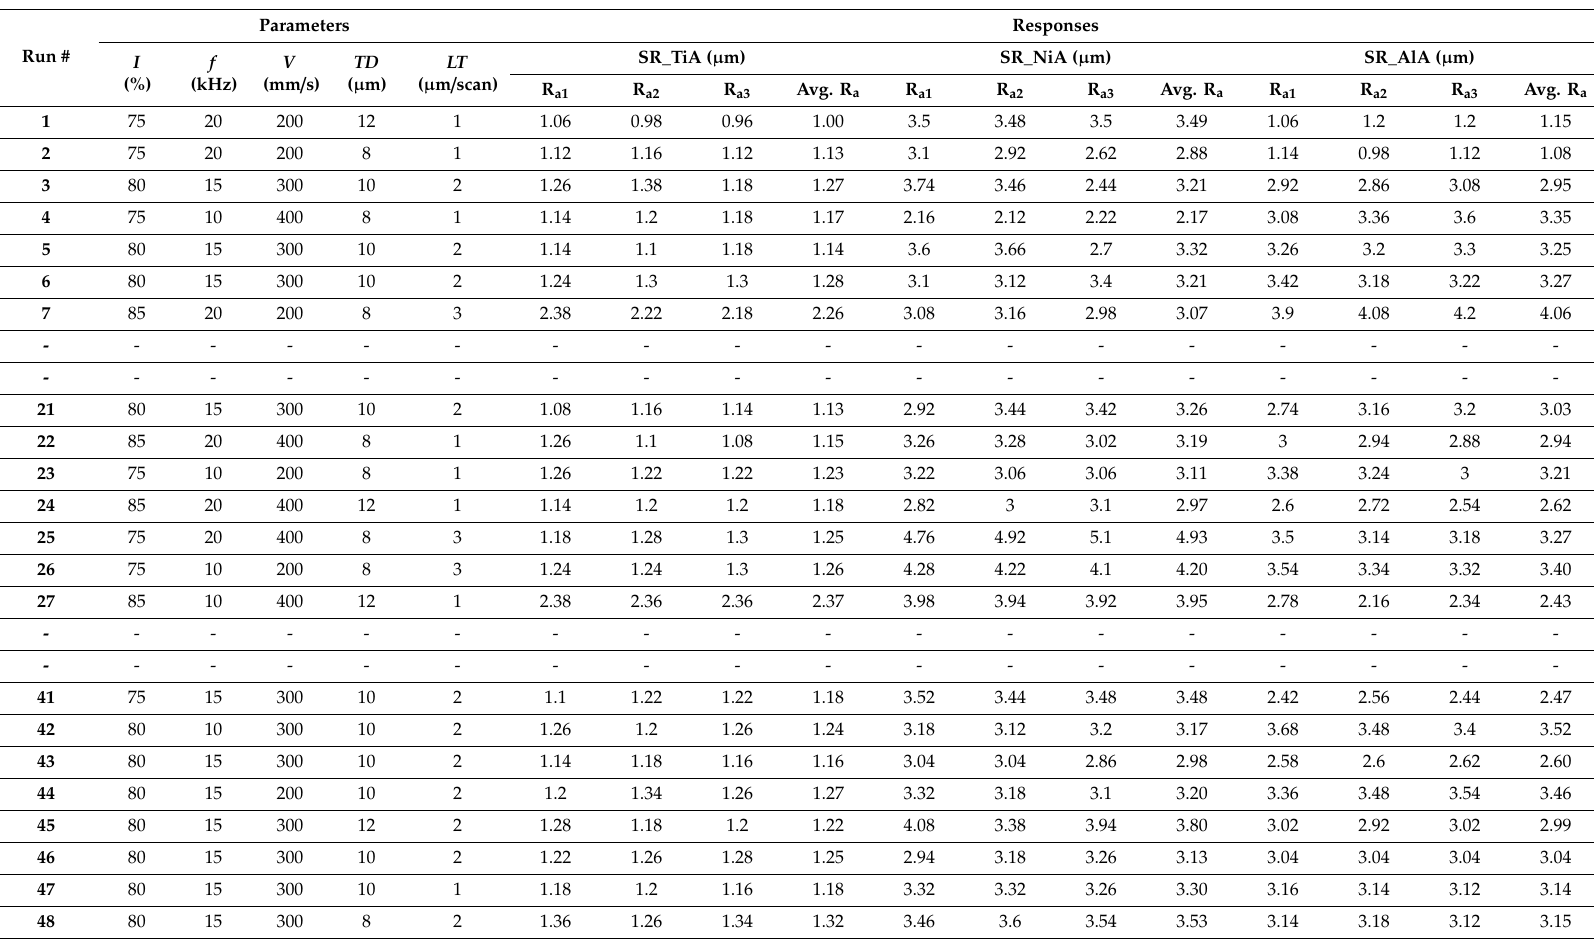
Table 3. Response surface methodology (RSM) with face centered central composite design (FCCCD) and the selected experimental results after laser beam machining (LBM) of titanium, nickel, and aluminum